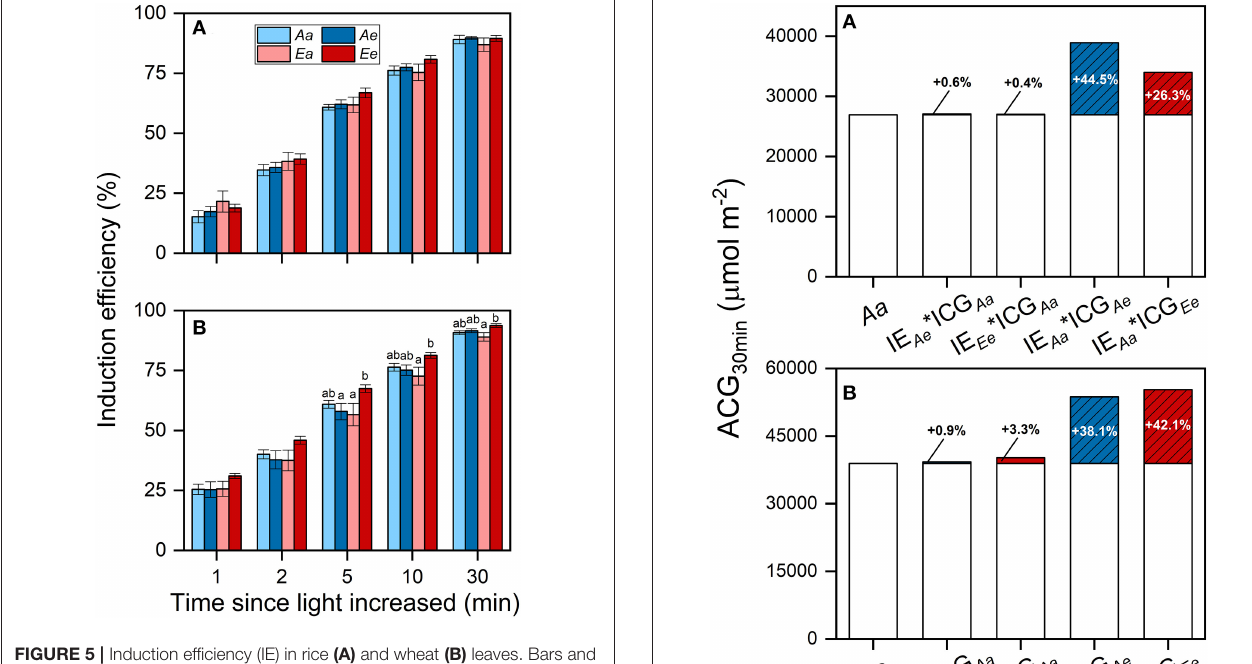
FIGURE 5 | Induction efficiency (IE) in rice (A) and wheat (B) leaves. Bars and vertical lines indicate the means and SEs of three to four biological replicates, i.e., individual plants for each species, respectively. Different letters above error bars indicate significant differences across treatments within each species. The absence of letters denotes the absence of significant difference. FIGURE 6 | The effects of eCO